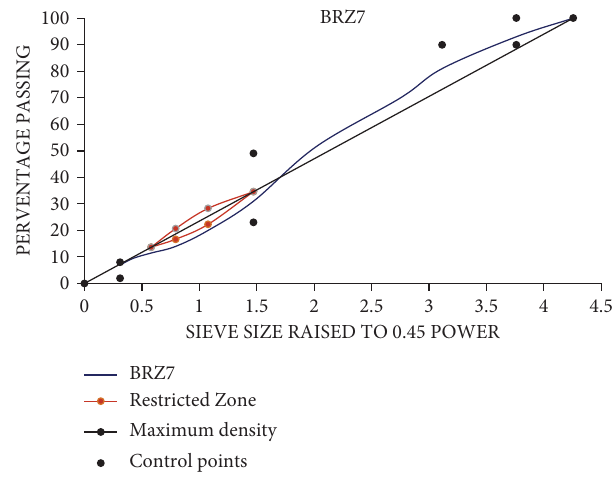
Figure 6: Superpave gradation using 0.45 power chart for 7% CSD